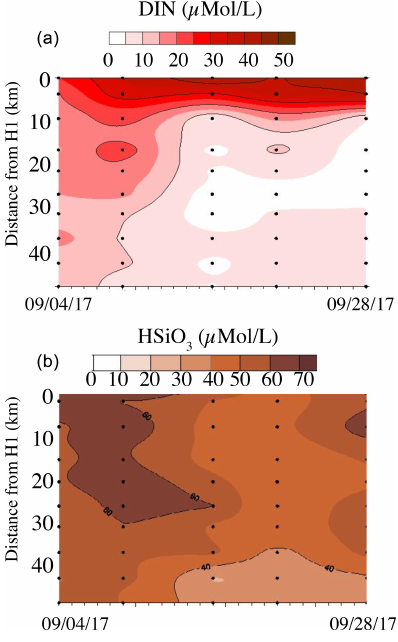
Figure 8. Surface nitrate plus nitrite (a) and silicate (b) concentra- tions (µmolL − 1 ) measured along a transect through Galveston Bay along the Houston Ship Channel (see Fig. 2b). Sampling dates were 4, 9, 16, 21 and 28 September 2017. Station H1 (0km) was the in- nermost station in the bay; H10 was just outside the breakwater in the Gulf (see Steichen et al., 2020, for